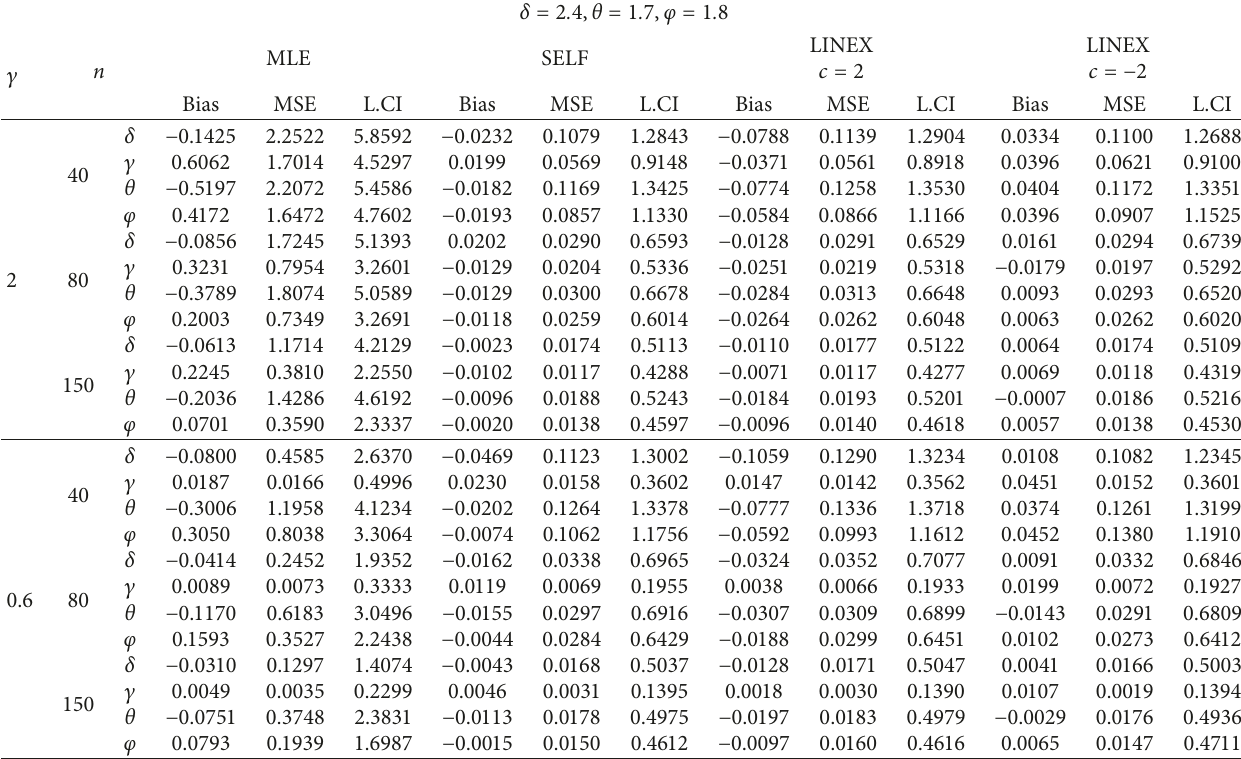
Table 6: Bias, MSE, and L. CI for MLE and BE for case III.